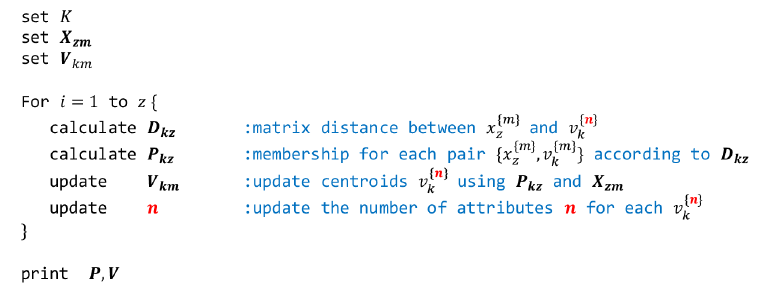
Figure 3. Pseudocode of a semisupervised algorithm based on k